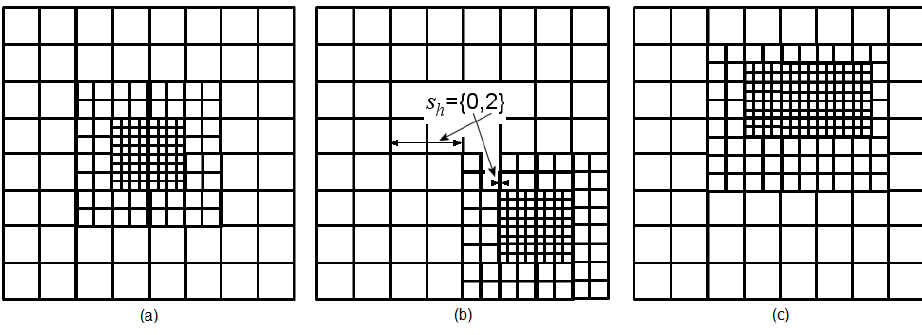
Figure 3. ( a ) Cartesian foveal geometry (CFG) with m = 3 and d = 2; ( b ) Shifted Fovea Multiresolution Geometry(SFMG) of generalized motion with s h = {0,2} and s v = {0,2} (we have marked in the